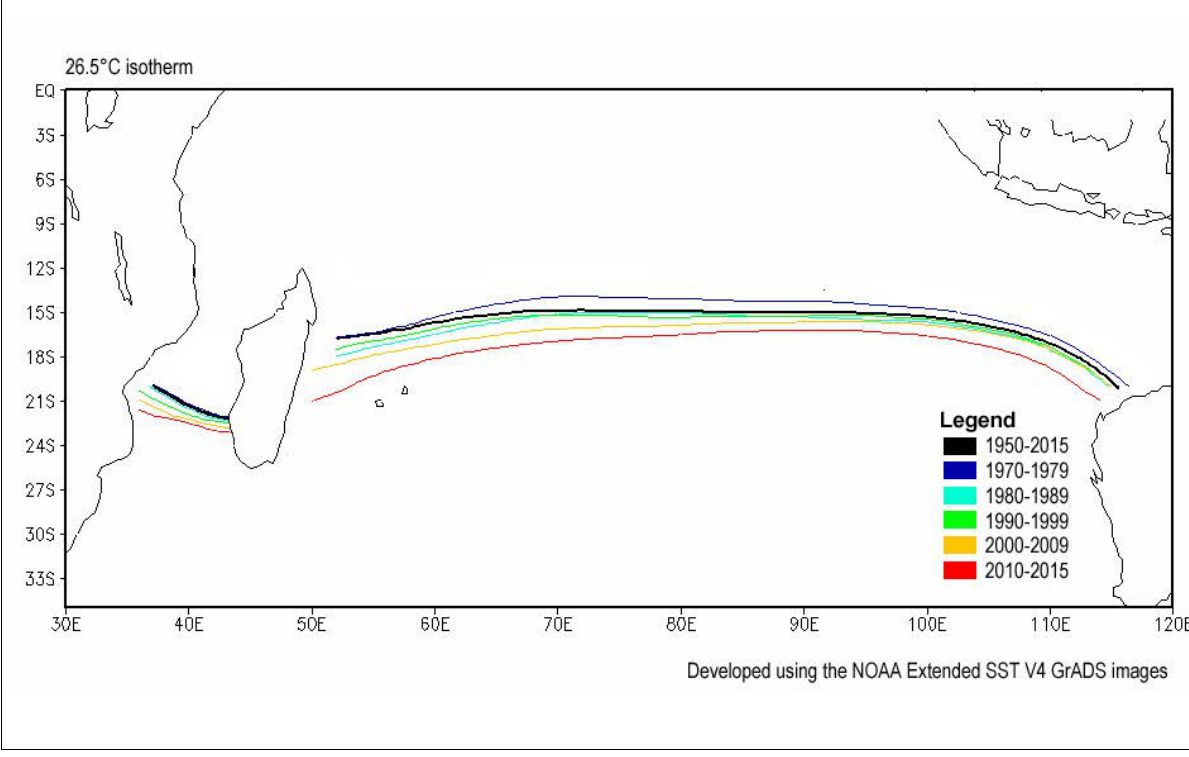
figure 2: Decadal mean position of the 26.5 °C sea surface temperature isotherm for the South Indian Ocean over the period 1970–2015, relative to the 1950–2015 long-term mean (black